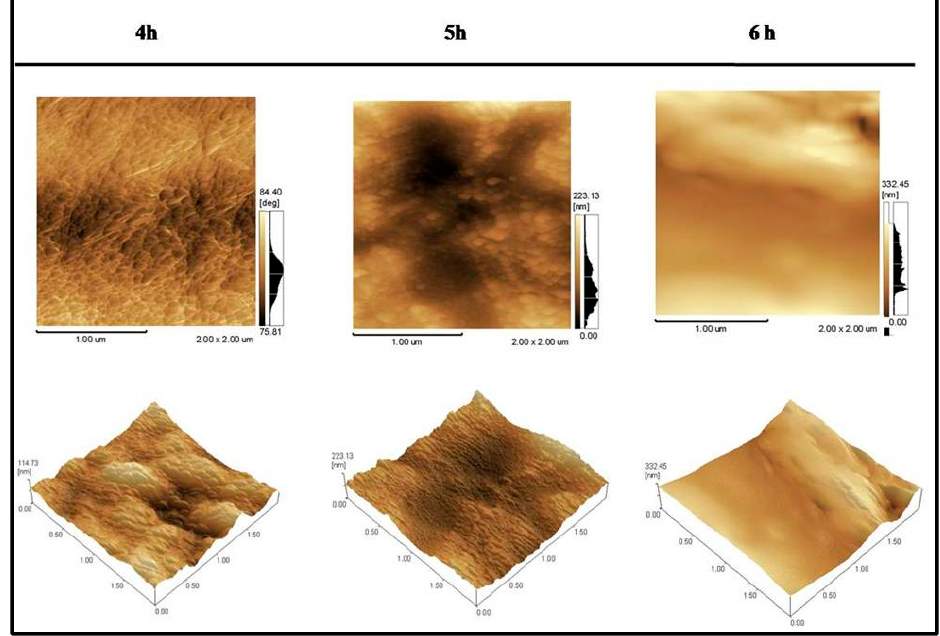
Figure 4. Images obtained in an atomic force electron microscope (AFM) after anodization process in NH 4 F 0.25% + glycerol at 30 V for 4, 5, and 6 h. The annealing process was performed at 530 °C (5 °C/min) for 1 h.